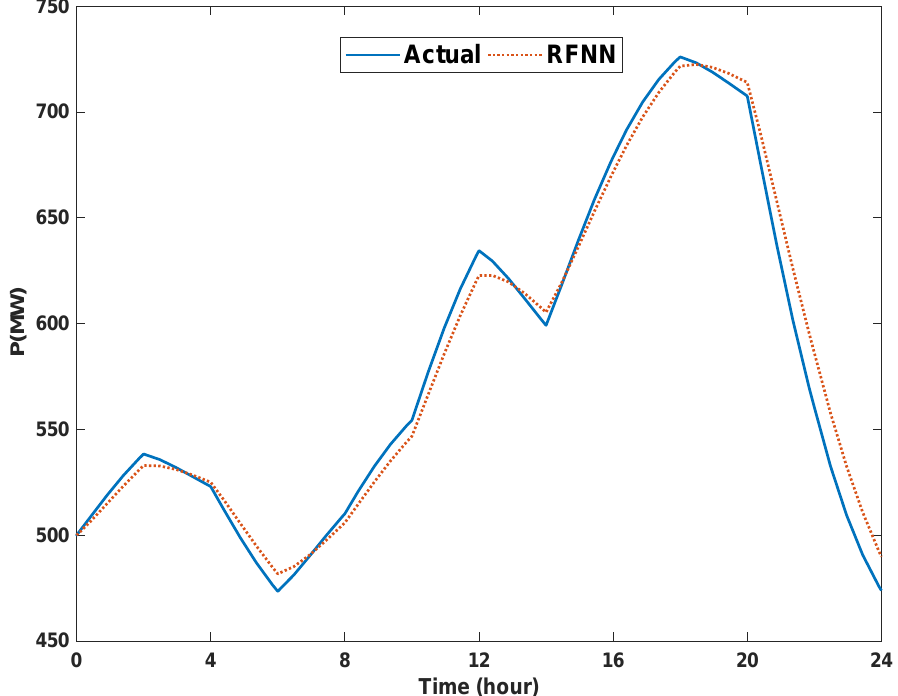
Figure 12. Forecasting result for 30 July